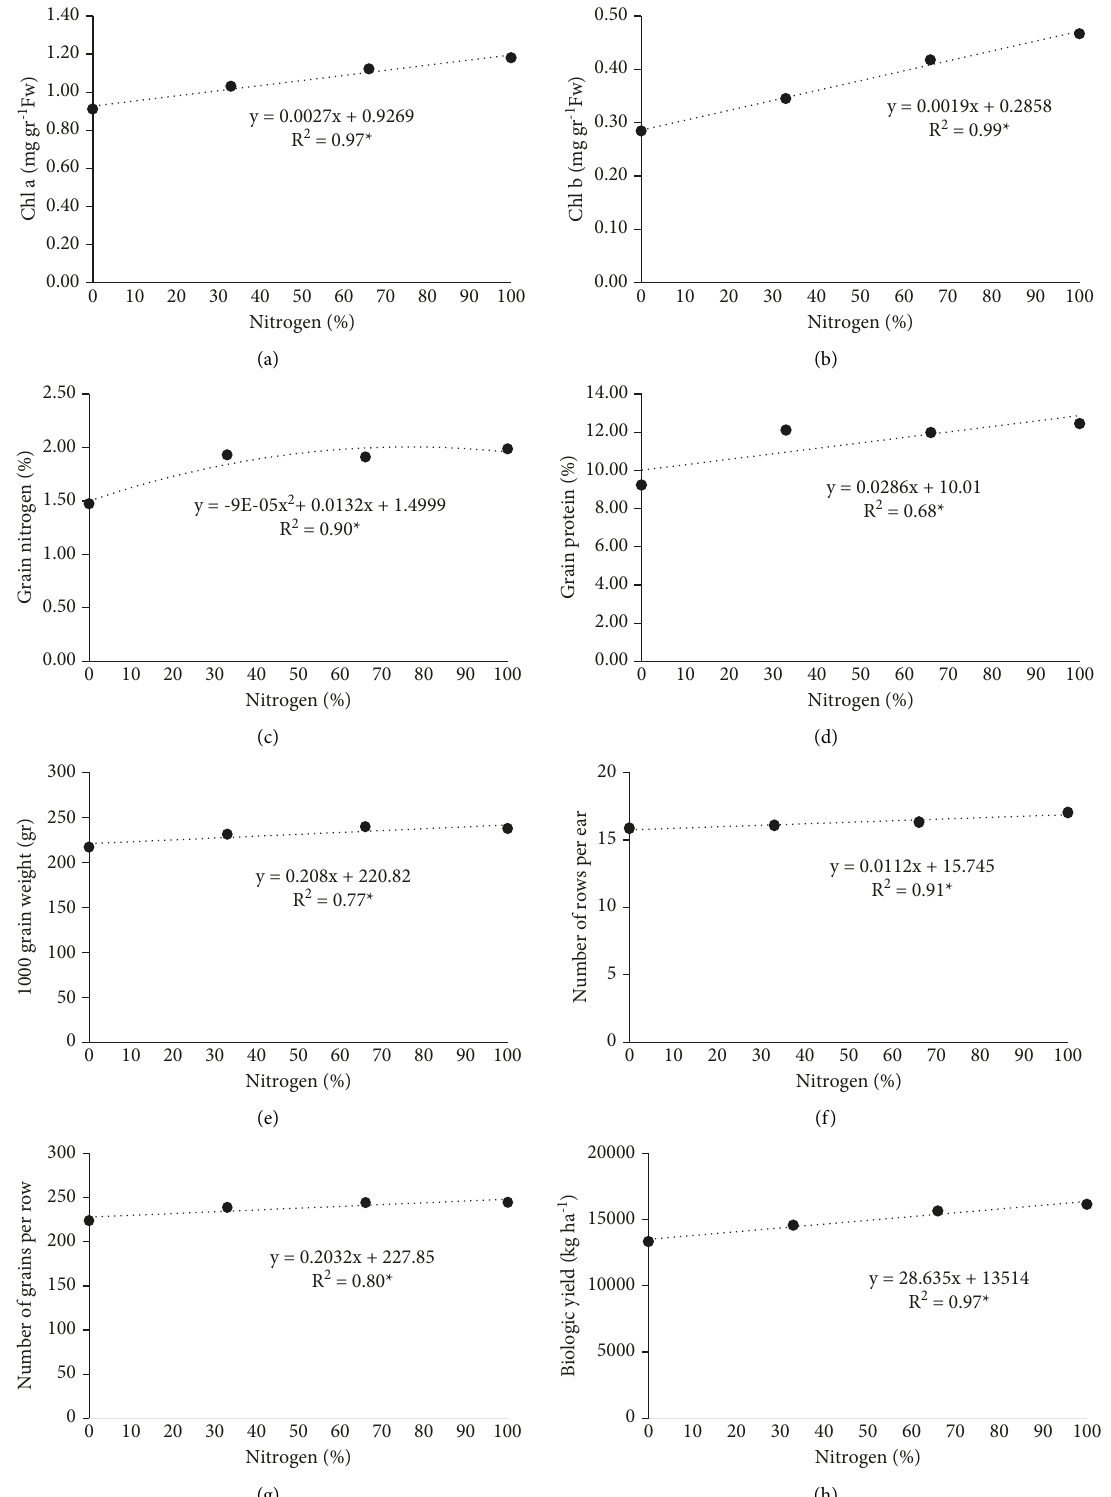
Figure 1: The trend of changes in nitrogen fertilizer levels on chlorophyll a (a), chlorophyll b (b), grain nitrogen (c), grain protein (d), 1000- grain weight (e), number of rows per ear (f), number of grains per row (g), and biological yield